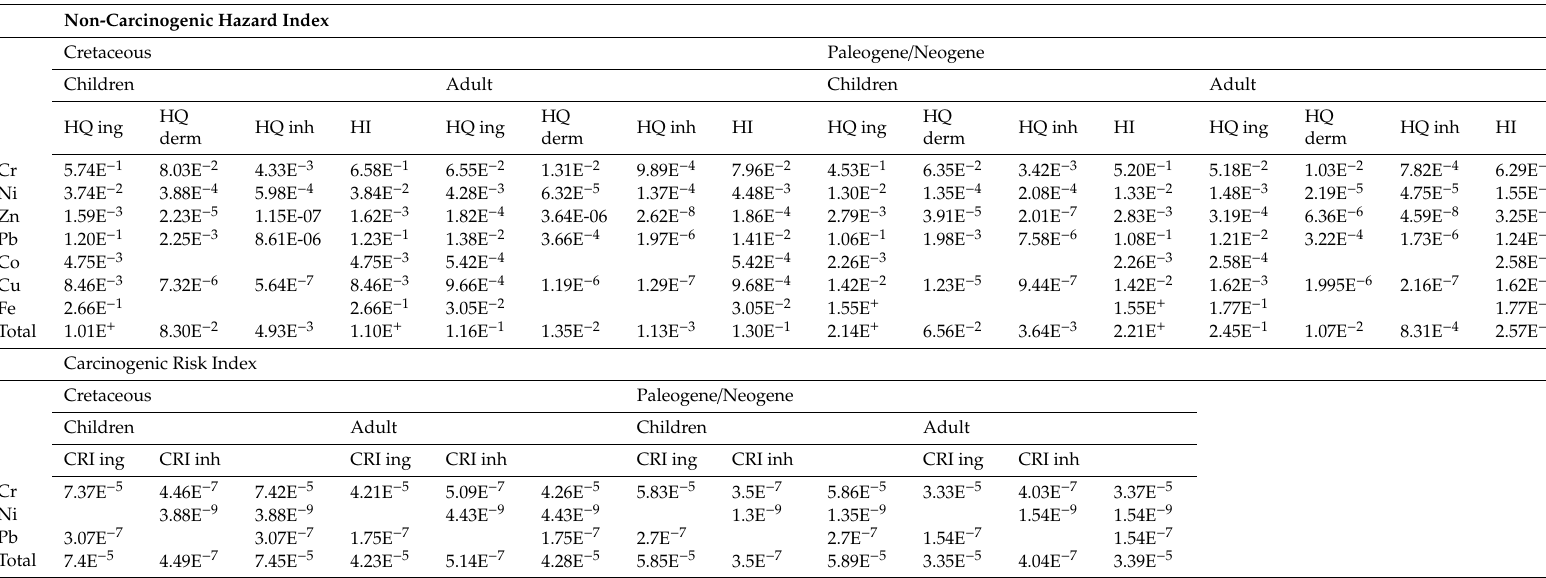
Table 5. Average health risks based on the average trace element concentrations in the Cretaceous and Paleogene / Neogene geophagic kaolinitic clays within Eastern Dahomey and Niger Delta Basins,